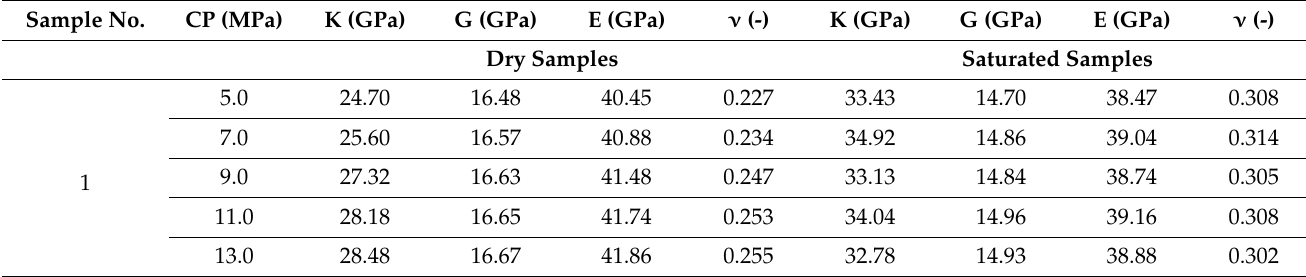
Table 2. Elastic parameters of the Pannonian Basin limestone cores. (CP—confining pressure; K—Bulk modulus; G—Shear modulus; E—Young’s modulus; ν —Poisson ratio). Sample Sample No. CP (MPa)